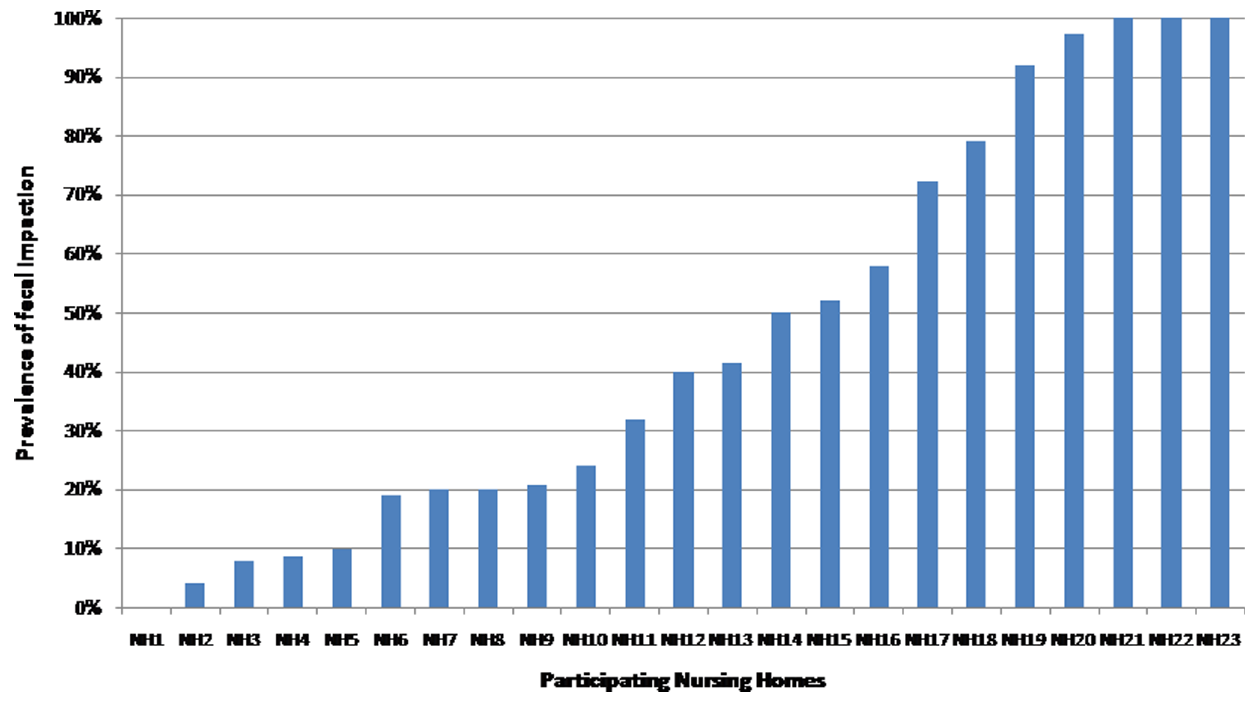
Figure 1. Annual prevalence of fecal impaction across the participating nursing hours.